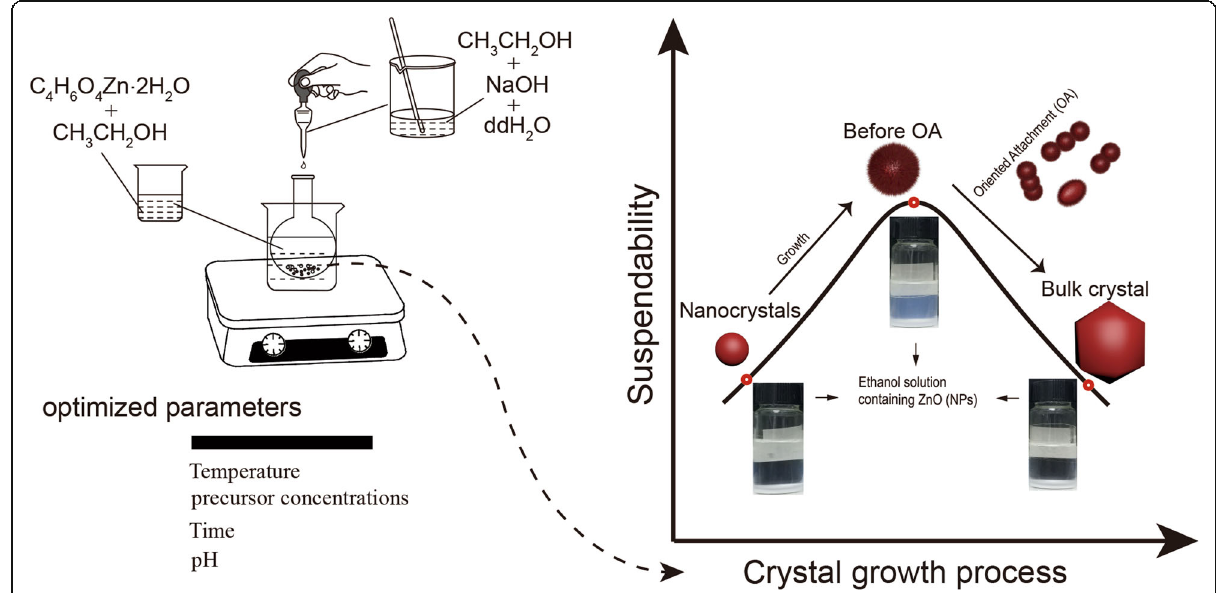
Scheme 1 Schematic illustration of ZnO NPs synthesis as well as the suspendability